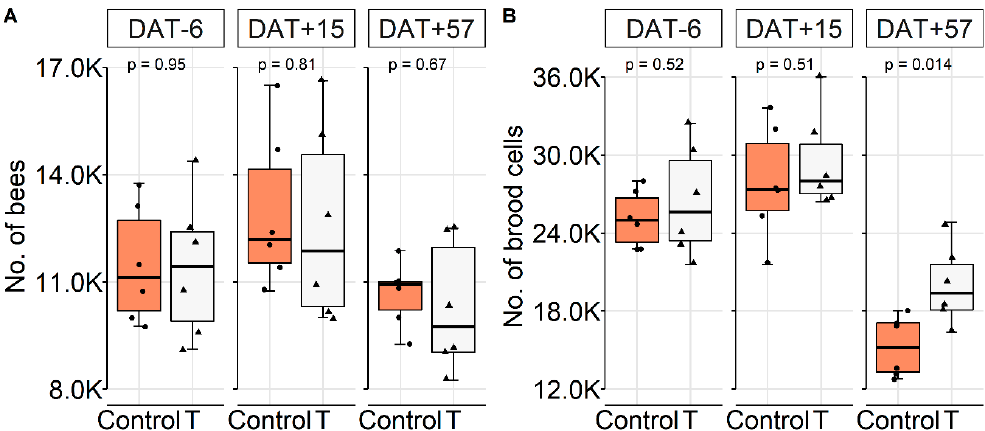
Figure 5. Effect of GBH field exposure (foliar spray) on colony conditions, displayed as boxplot. ( A ) Number of worker bees. ( B ) Number of brood cells during the study. On DAT+57, the treatment T had significantly more brood cells when compared to the control (Wilcoxon rank-sum test). For all other assessments, conditions were not significantly different. Dates correspond to the following months: DAT − 6 (=20 July), DAT+15 (=10 August), and DAT+57 (=21